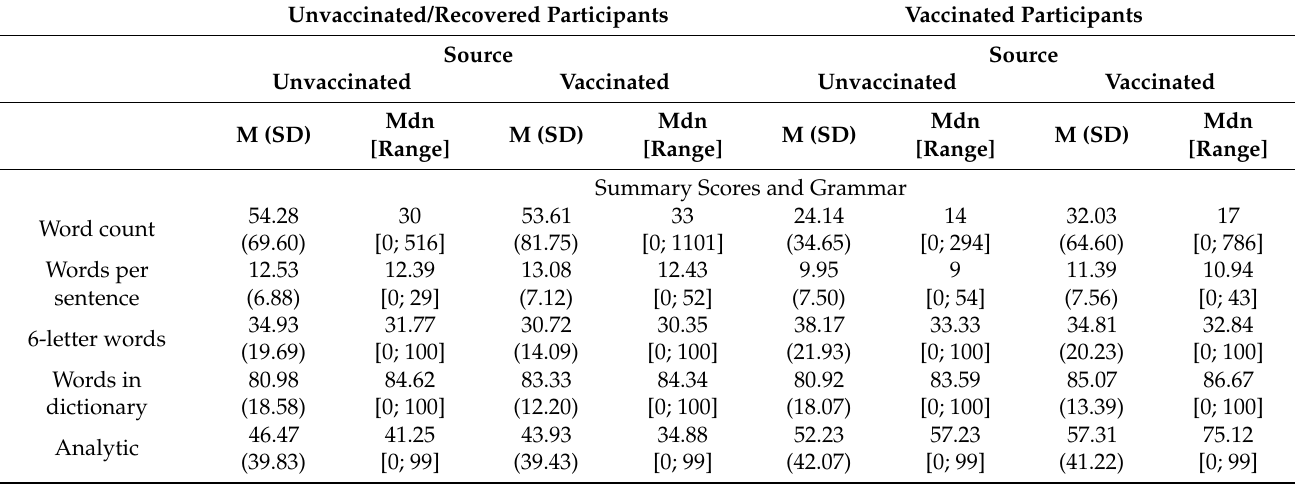
Table 1. Means and medians by Source and Participant vaccination status 1 .